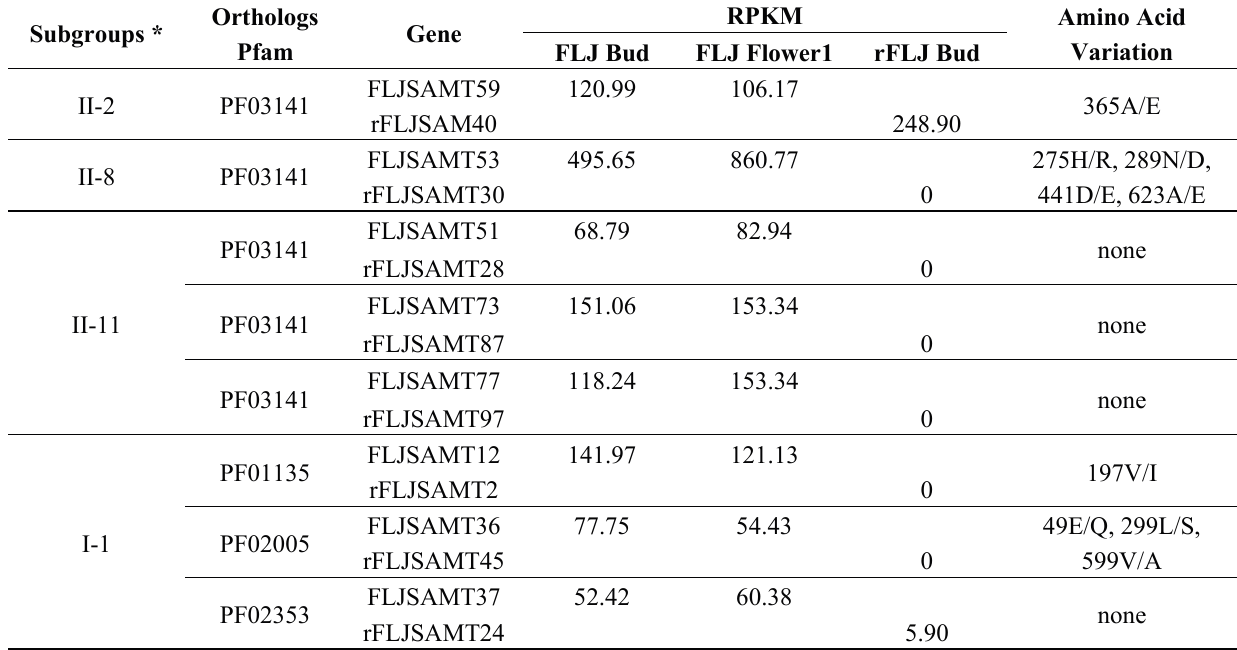
Table 3. Gene expression and amino acid variation of SAMe genes in